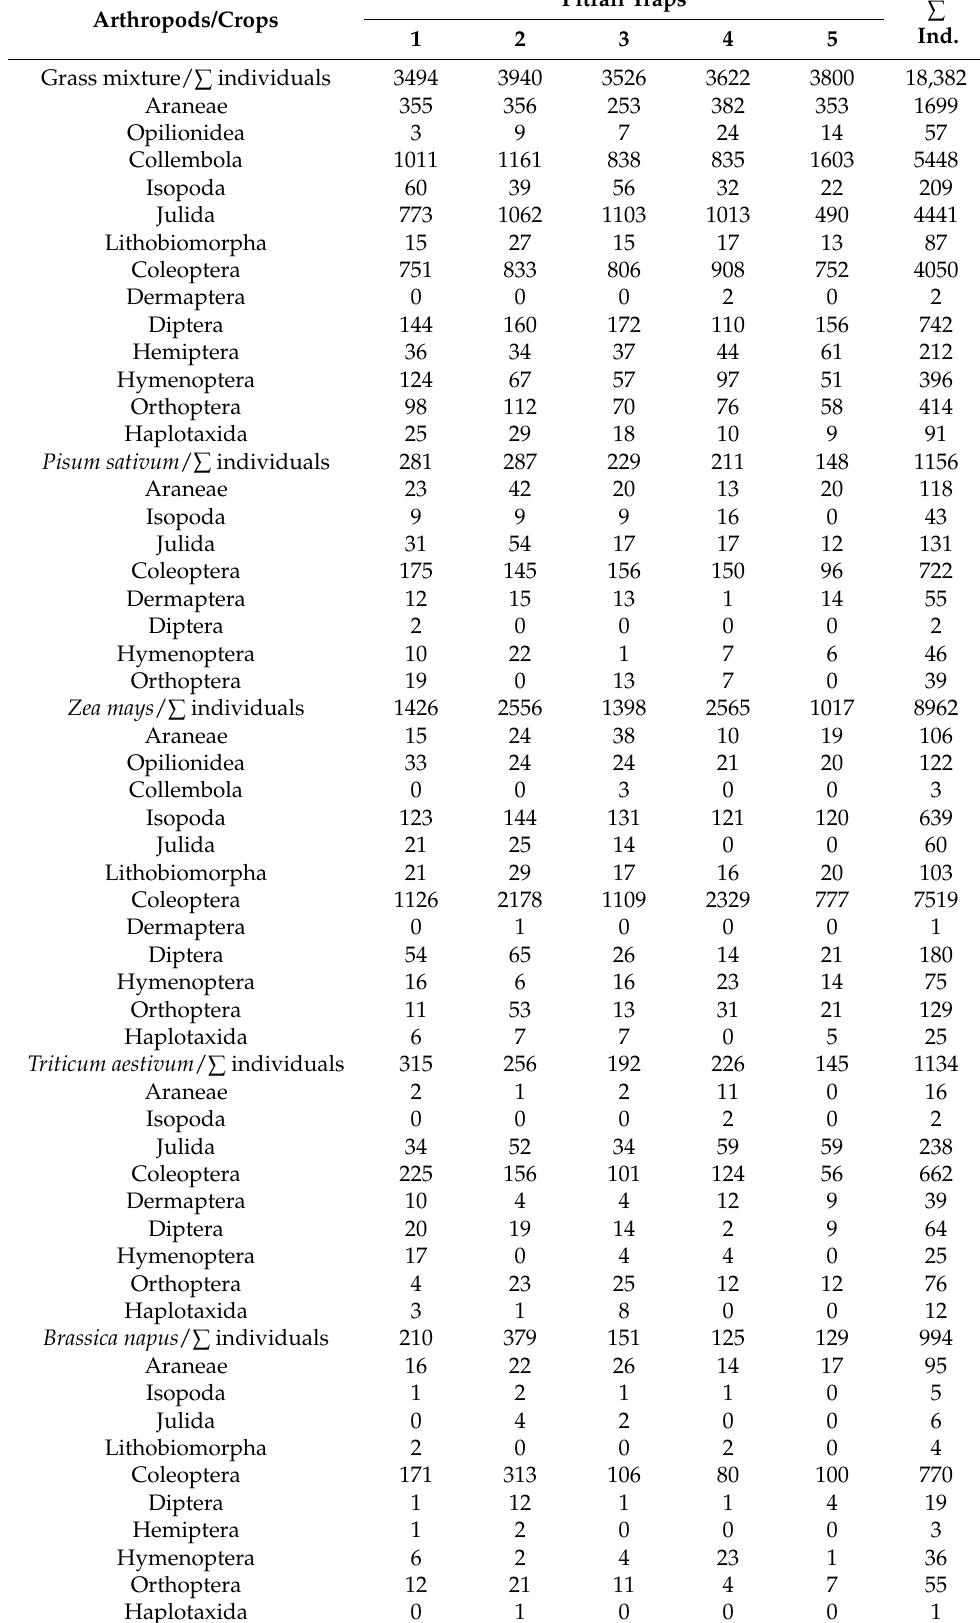
Table 2. Distribution of the arthropods in the agricultural crops during the years